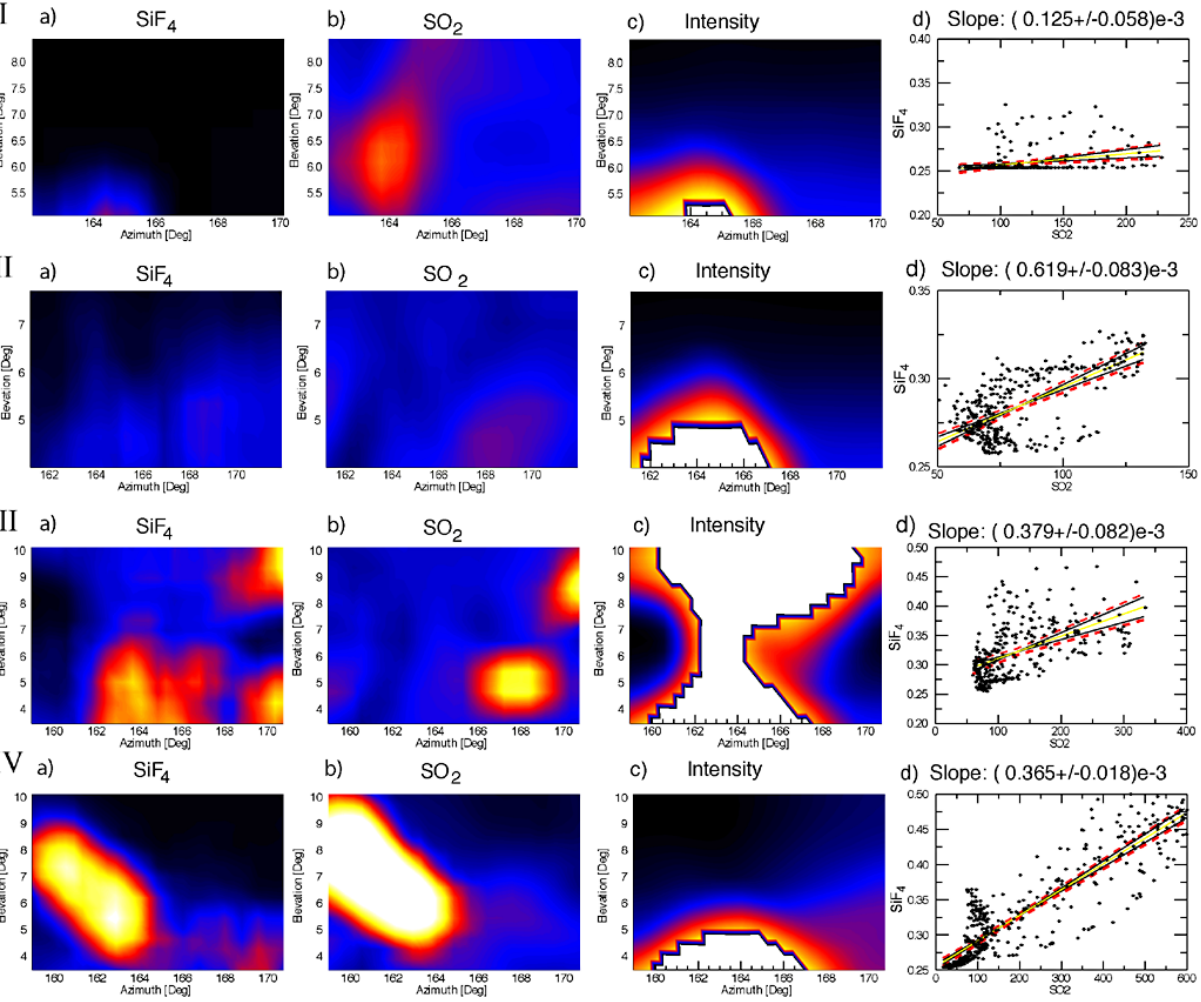
Fig. 12. Visualization of the (a) SO 2 and (b) SiF 4 slant columns retrieved at different times during the night of 16 to 17 November 2008 (colorbar for SiF 4 and SO 2 is the same as in Fig. 11). The integrated intensity around 900–1000cm − 1 is shown in (c) with colors in arbitray units. The linear fits from the plots in (d) are calculated only from pixels with lower intensities – those with color in (c) . A wind direction change is evident from the last row and one reference spectrum as clear sky was used for all the analysis (see video S.2 in the